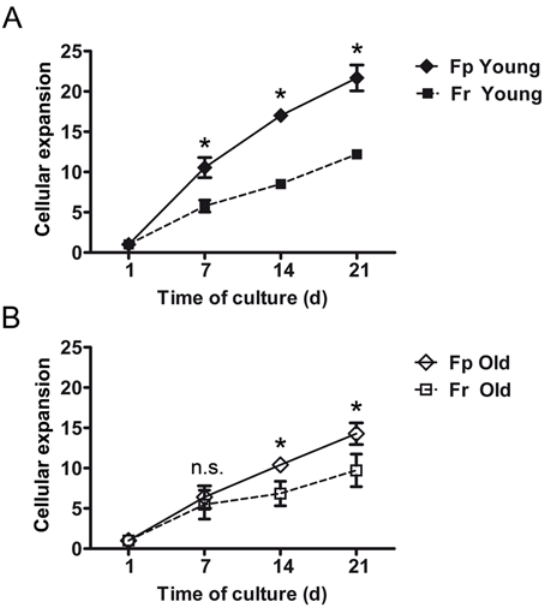
Figure 5. Age-related growth characteristics of Fp and Fr. Fp and Fr samples from 3 young (19 yr, 19 yr, and 26 yr) and 3 old donors (57 yr, 58 yr, and 67 yr) were cultured for 21 days. Cellular growth rate was estimated every 7 days after culture initiation. Data are expressed as cumulative expansion curves (means 6 SEM, n=3 independent samples). (A) Comparison of growth rates of Fp and Fr from young donors. (B) Comparison of growth rates of Fp and Fr from old donors (*p , 0.05; n.s.=not significant).